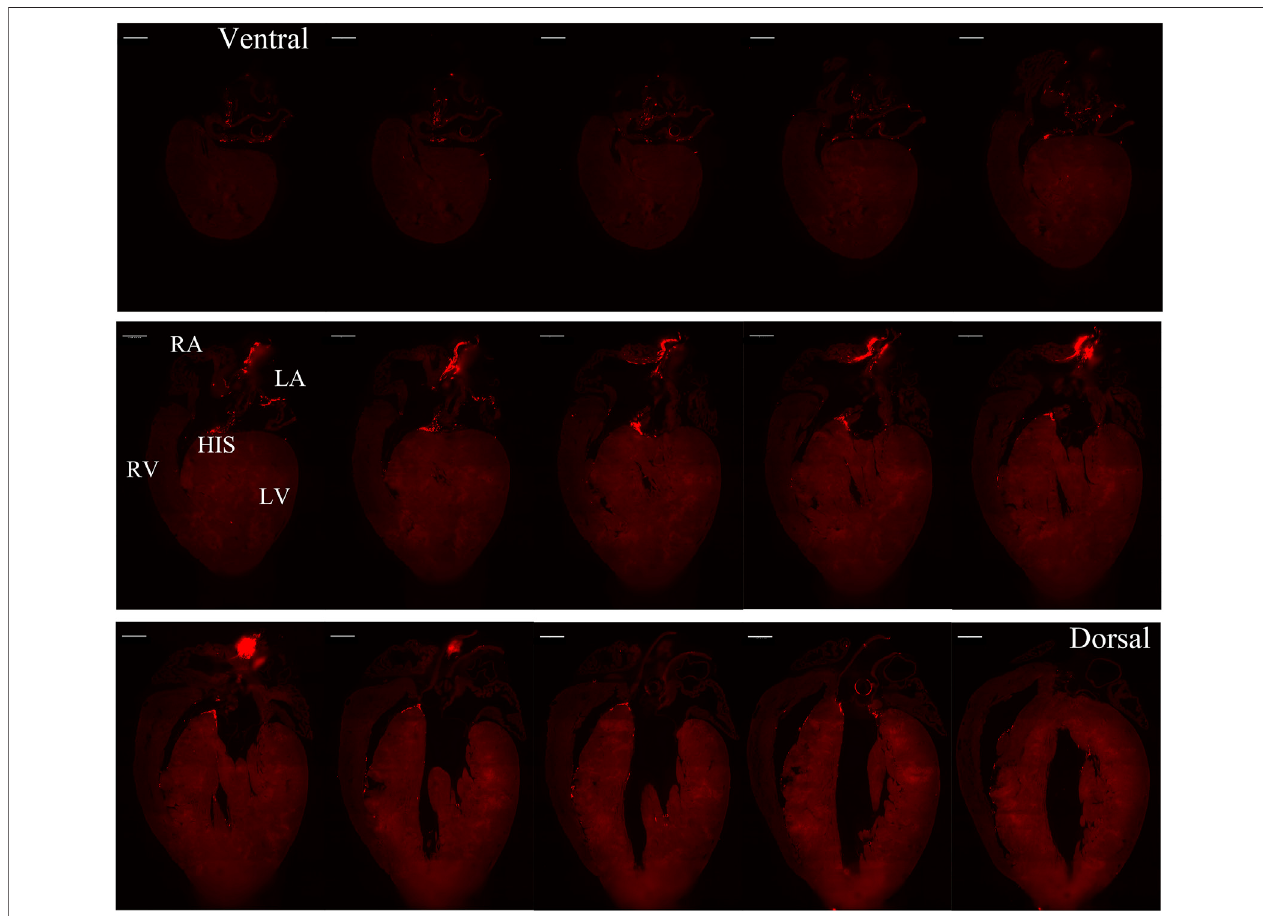
FIGURE 3 | Selected representative coronal sections of Hcn4 DreER/tdTomato showing the distribution of HCN4+ cells from ventral side to dorsal side in adult mouse heart. Scale bar: 1,000 μ m.